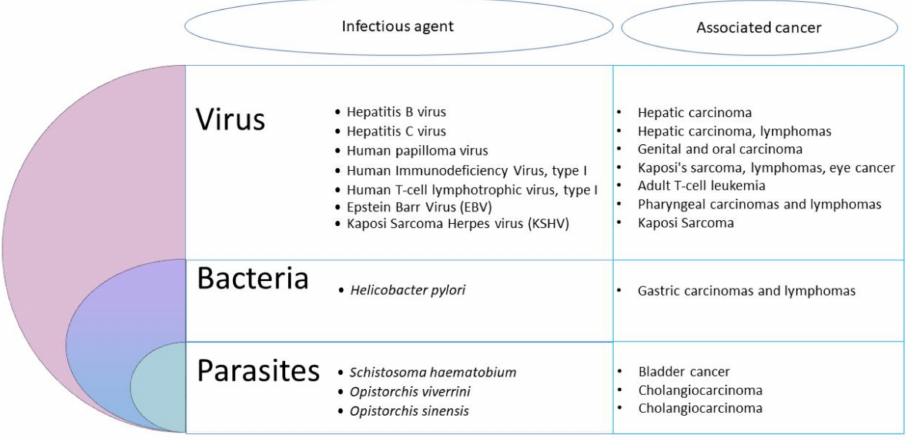
Figure 1. Infectious agents recognized by the International Agency for Research on Cancer (IARC) as major contributors to the global number of